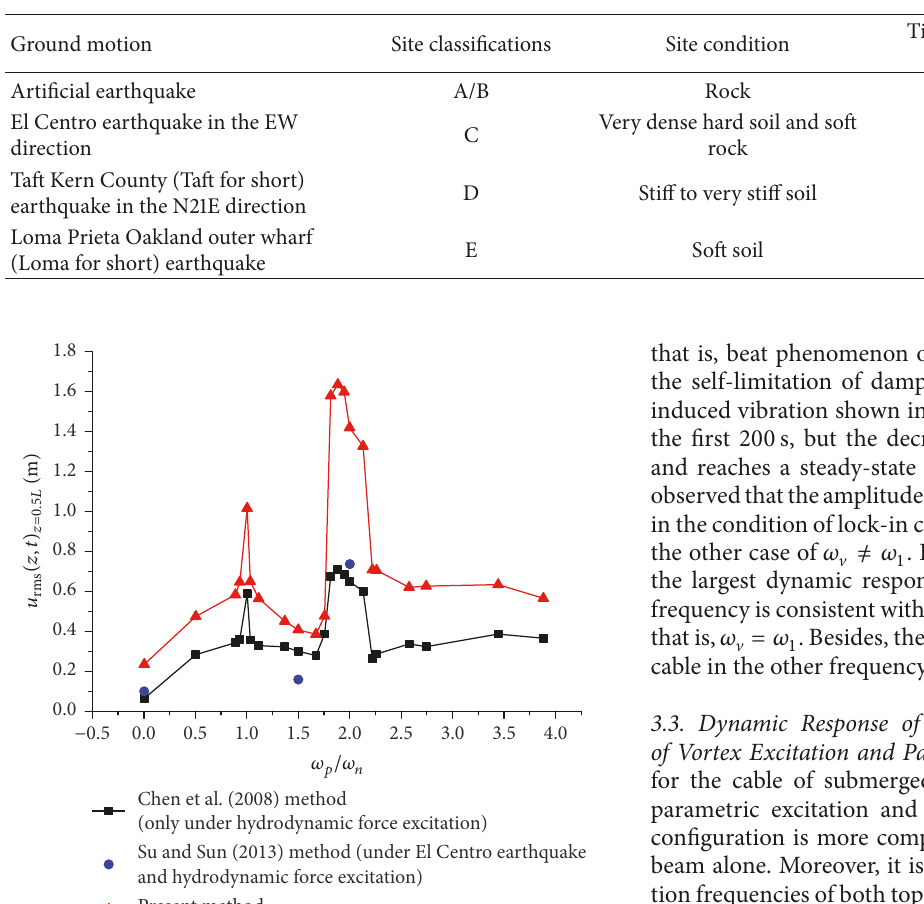
Table 2: Site classifications of earthquake records used for this study.